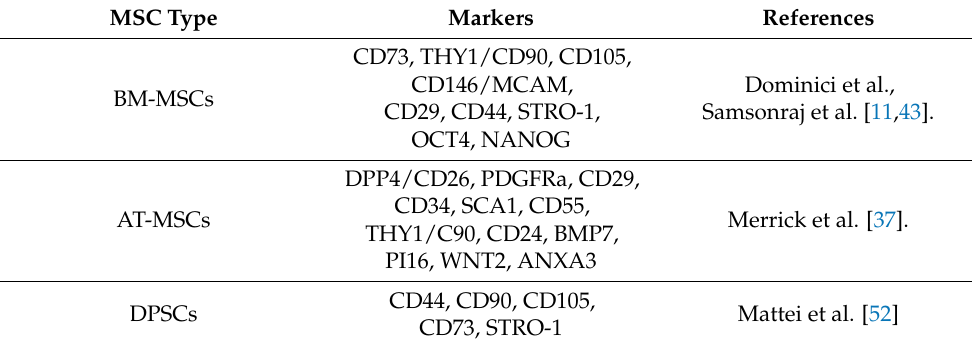
Table 1. MSC markers reported in